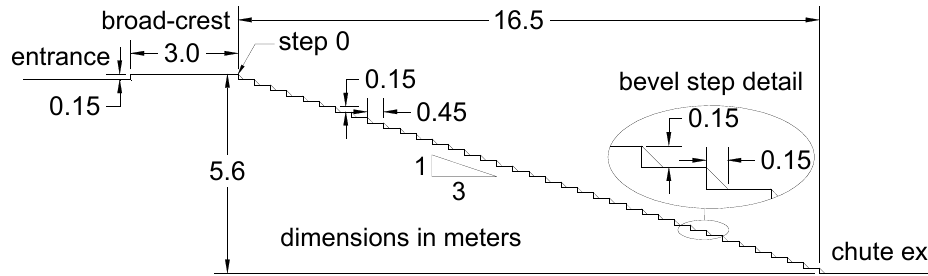
Figure 2. Schematic of a stepped chute model with beveled face steps.